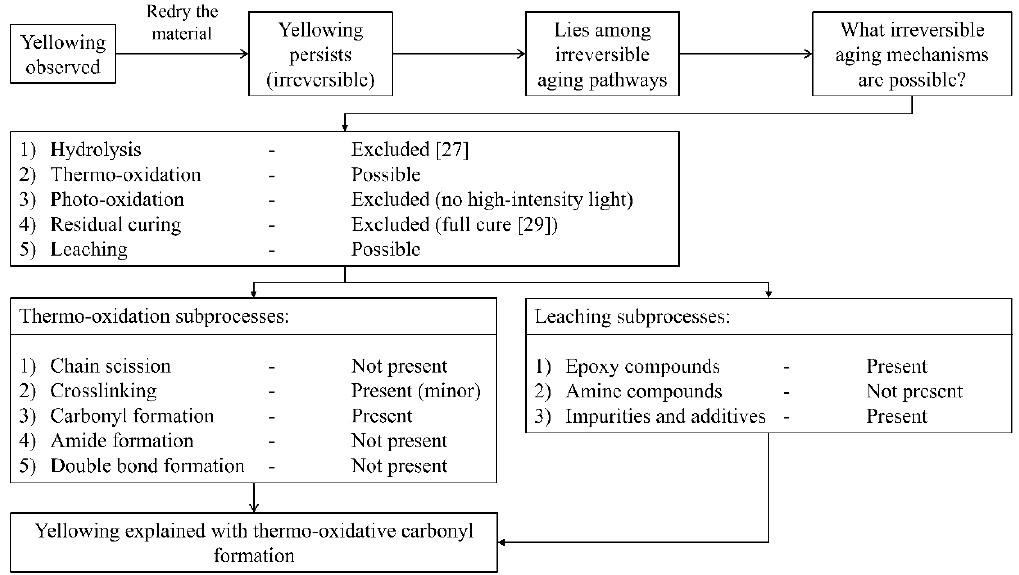
Figure 9. Schematic representation of the logic during